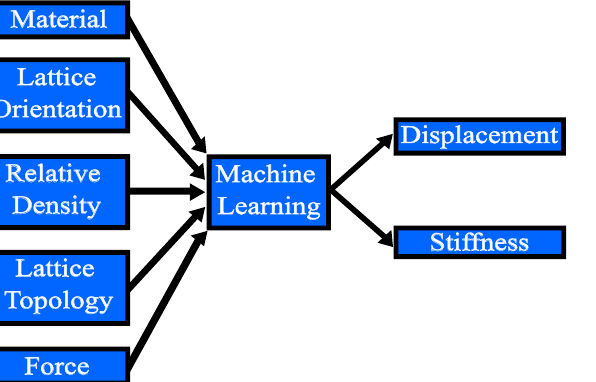
Figure 8. Diagram of the normal learning method of the parameters of the lattice-compliant cross-axis